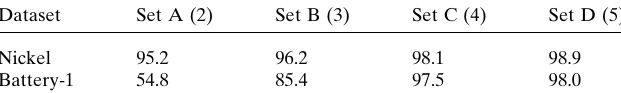
Table 5 Overall predicted TP rates in percentage of Nickel and Battery-1 datasets against varying feature sets. The numbers in parentheses represent the number of features for each